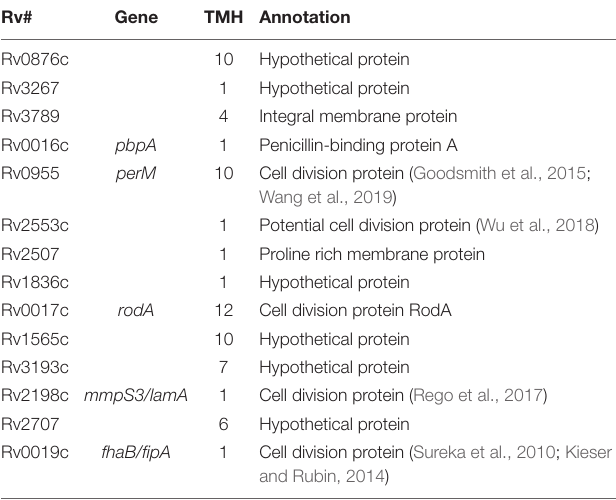
TABLE 4 | Underrepresented Tnseq hits in (cid:49) rv0954 that encode integral membrane